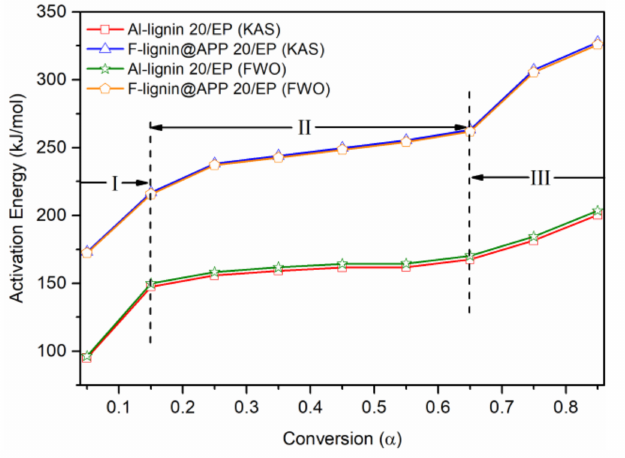
Figure 9. Activation energy of Al-lignin 20 / EP and F-lignin@APP20 / EP at di ff erent